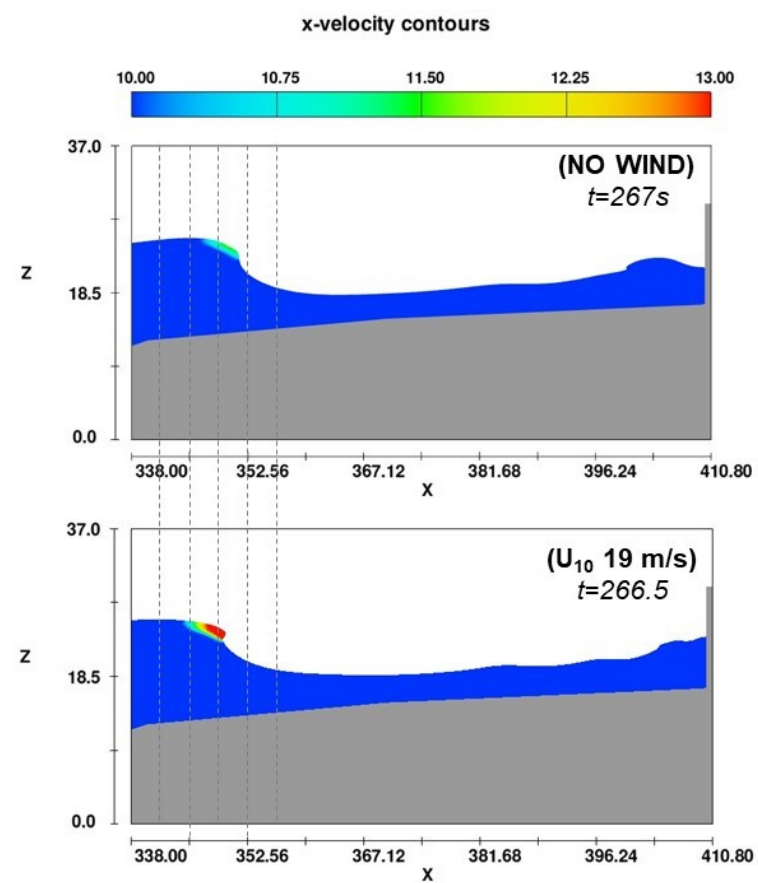
Figure 9. Incipient breaking condition with and without wind (TEST_1and Rc = +10.00 m).